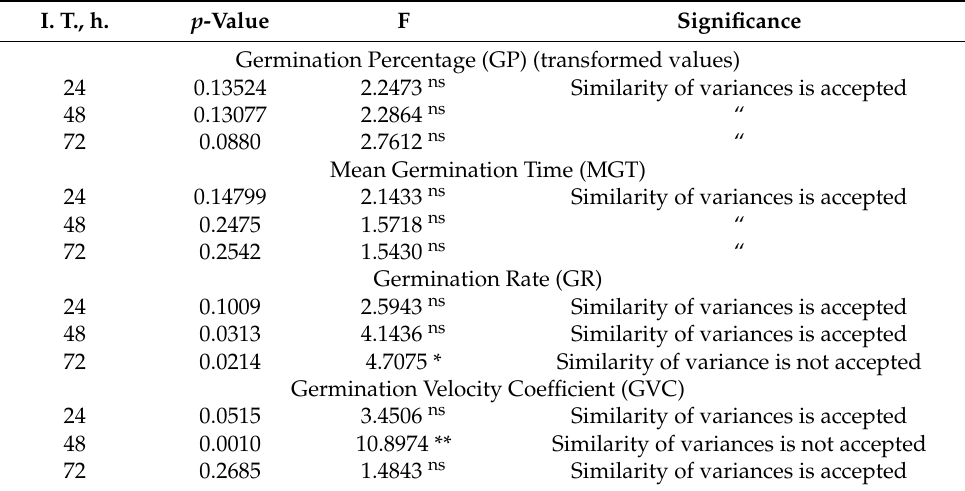
Table 2. Homoscedasticity test for the variables germination percentage (GP) (transformed values), mean germination time (MGT), germination rate (GR) and germination velocity coefficient (GVC). I. T., h. p -Value